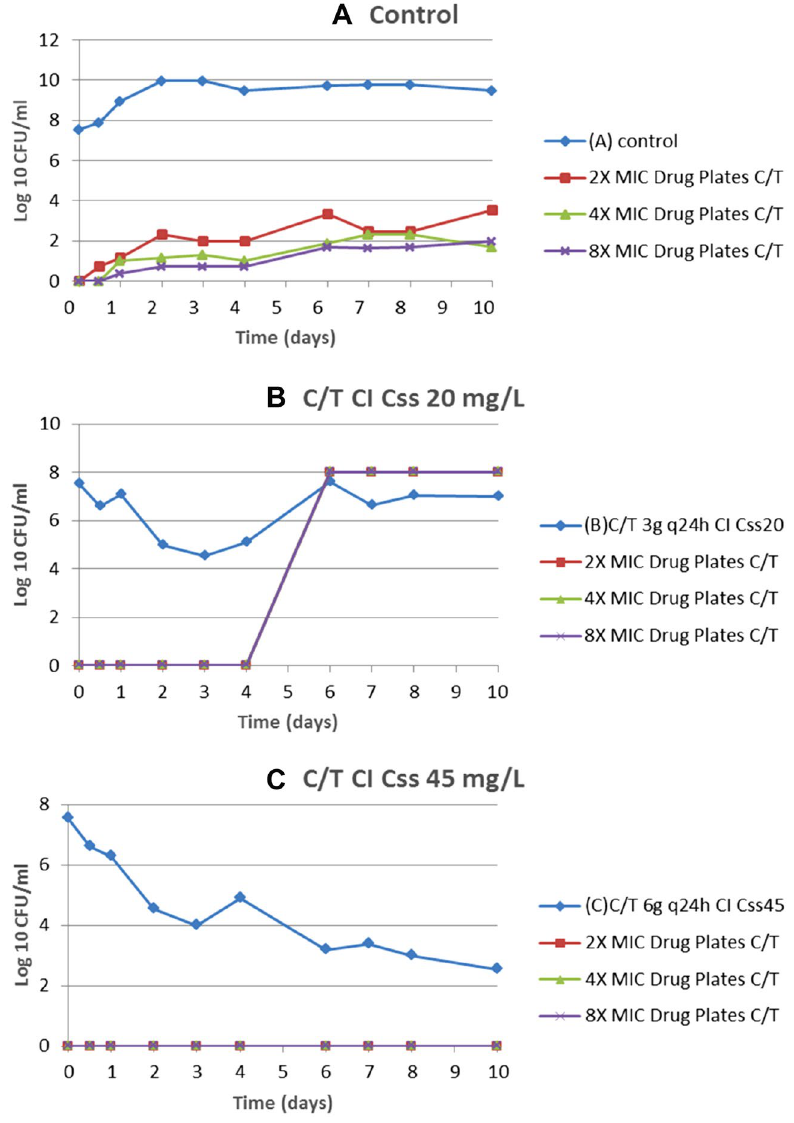
Figure 3. Emergence of C/T resistance in the ST175 (10-023) isolate using Css of 20 and 45 mg/L in CI. C/T, ceftolozane/tazobactam; CI, continuous infusion; Css, steady-state concentration; MIC, minimum inhibitory